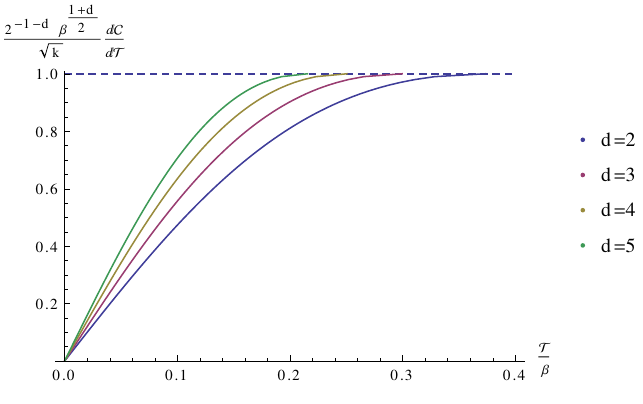
Figure 5 . Plot of (6.31) for d = 2 ; : : : ; 5, larger d hugs the in(cid:12)nite time line